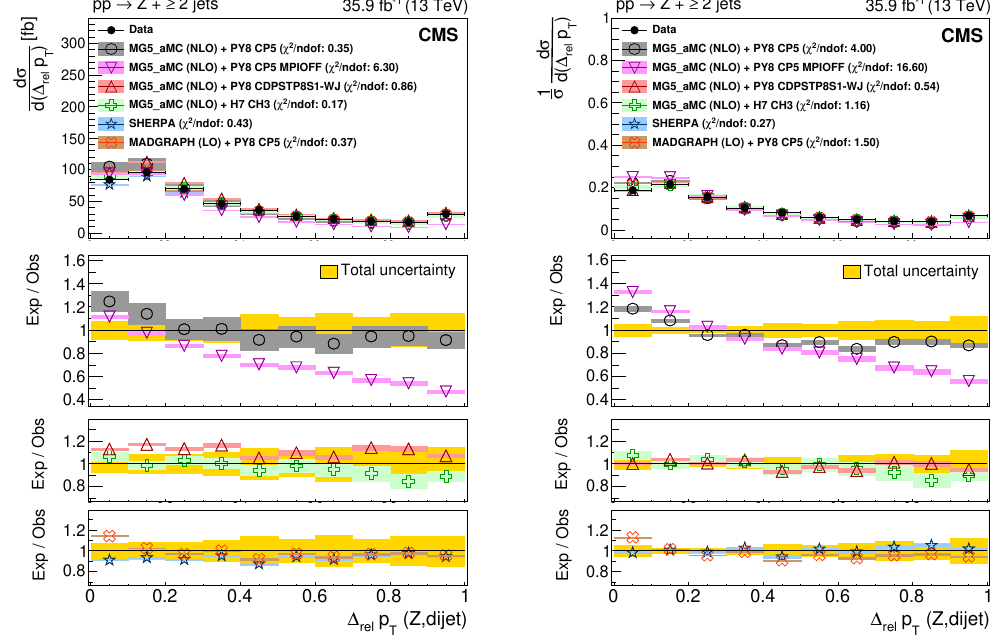
Figure 5 . Differential cross sections (left) and area-normalized distributions (right) as functions of the p imbalance between the Z boson and the dijet for Z + ≥ 2 jet events. The uncertainties in T the predictions are shown as coloured bands around the theoretical predictions including statistical, PDF, scale, and tune uncertainties for the NLO MG5_aMC + pythia 8 (with CP5 tune) and the statistical uncertainty only for the LO MG5_aMC + pythia 8 (with CP5 tune), NLO MG5_aMC + pythia 8 (with CDPSTP8S1-WJ tune, CP5 tune with MPI-OFF), NLO MG5_aMC + herwig 7 (with tune CH3), and sherpa predictions. In the top panel, the vertical bars on the data points represent statistical uncertainties, whereas in the bottom panels, the total uncertainty in data is indicated by the solid yellow band centred at 1. In the legend, the χ 2 per degree of freedom is given to quantify the goodness of fit of the model to the